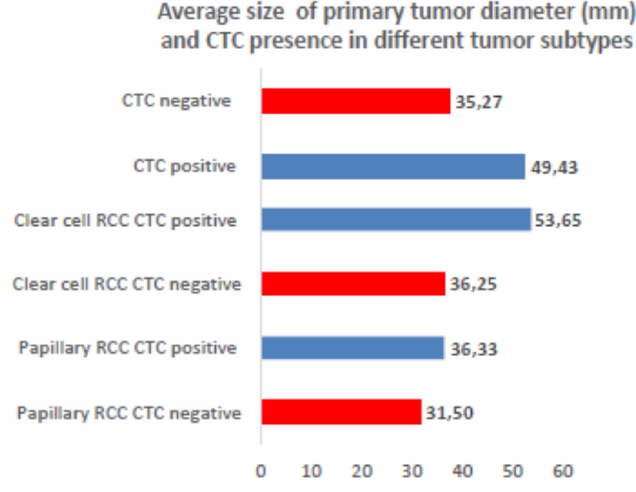
Figure 3. CTC—number (average per 1 mL of blood) detected in RCC patients for one-year follow-up in four blood samplings showing differences in CTC load between ccRCC and other RC types.